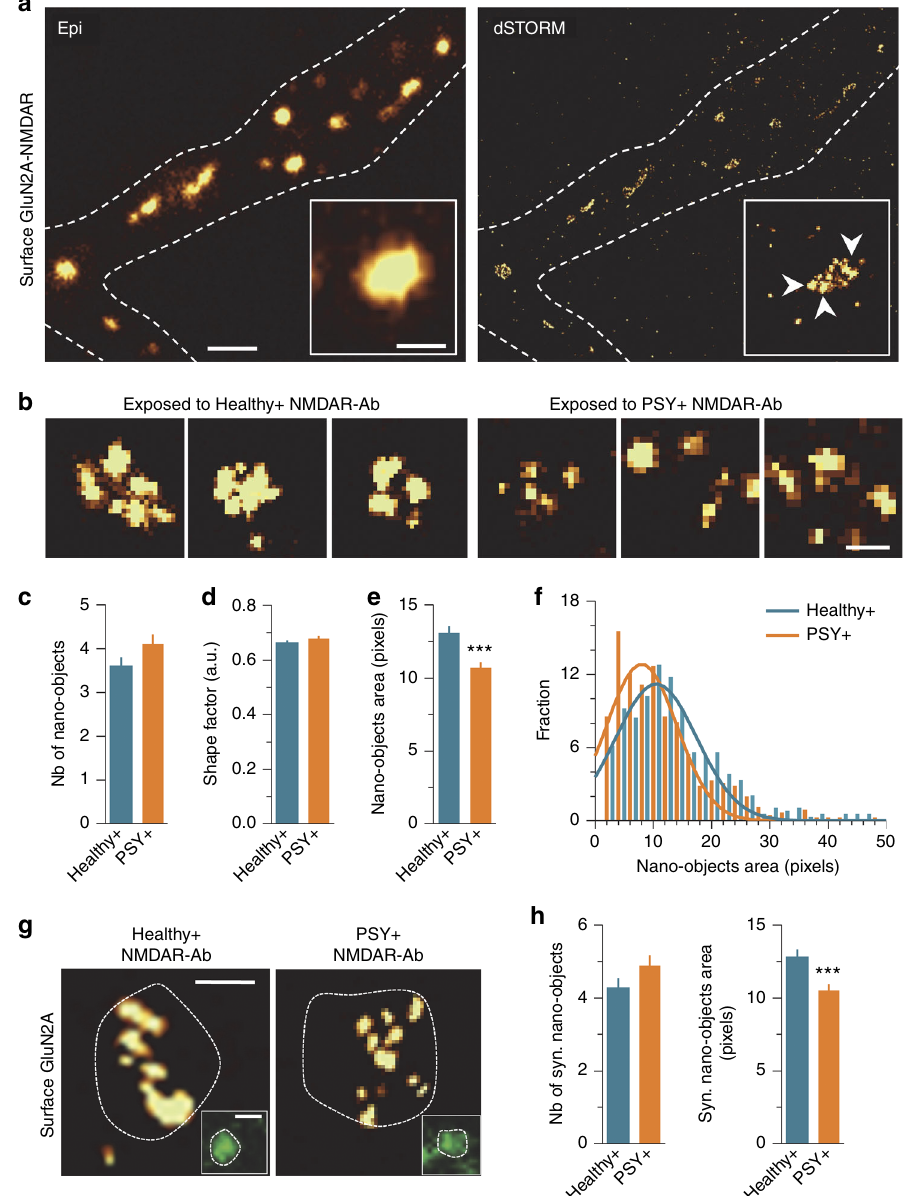
Fig. 4 Super-resolved map of GluN2A-NMDAR surface organization in presence of Healthy + and PSY + NMDAR-Ab. a Epi fl uorescence and dSTORM image of a dendritic segment with endogenous GluN2A-NMDAR staining. Scale bar, 1 µ m. Insert panel, magni fi cation of an isolated GluN2A-NMDAR cluster. Scale bar, 300 nm. b Representative examples of GluN2A-NMDAR nano-objects imaged by dSTORM after incubation with either Healthy + or PSY + NMDAR-Ab. One out of three Healthy + and 1/9 PSY + puri fi ed IgG samples were used and pooled for comparisons. Scale bar, 400 nm. c Mean ± SEM of GluN2A-NMDAR nano-object numbers after exposure to Healthy + ( n = 109 nano-objects, N = 4 neuronal fi elds) or PSY + ( n = 112, N = 5) NMDAR-Ab ( P